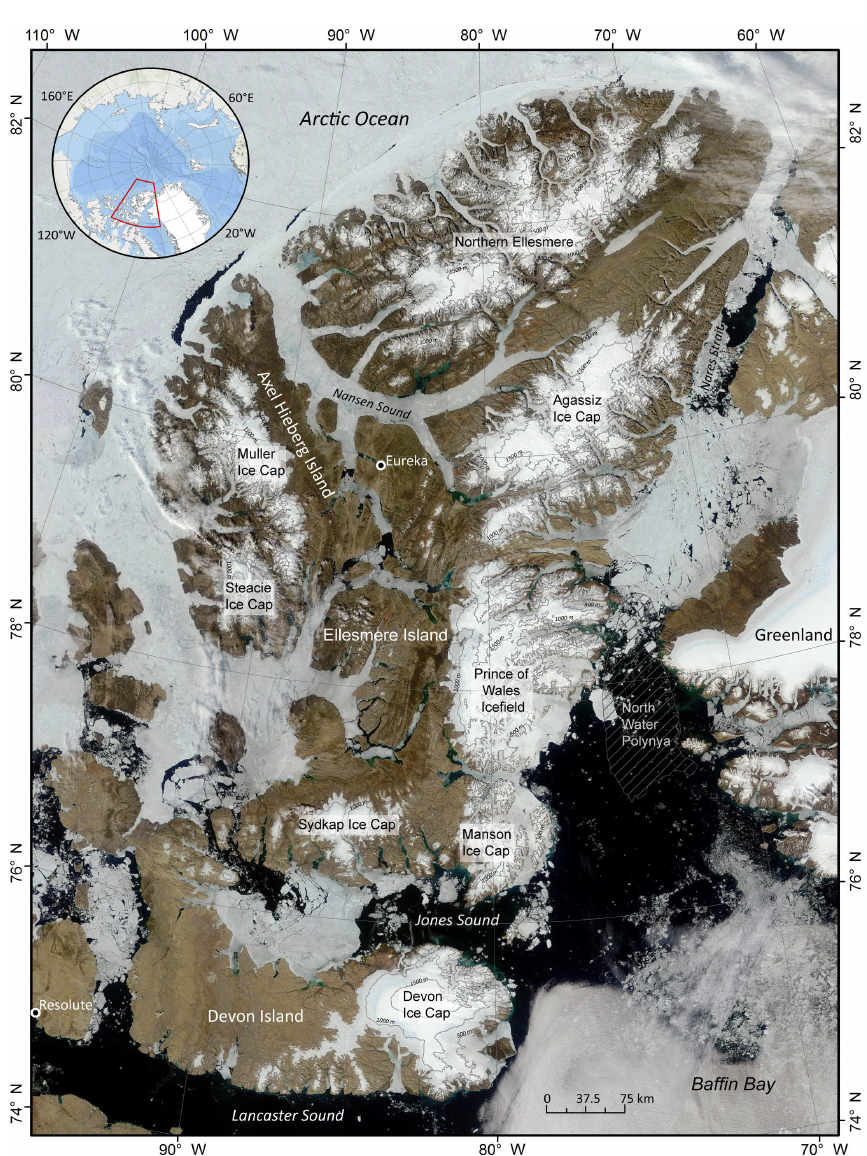
Figure 1. Glaciated regions of the Queen Elizabeth Islands (QEI). Background image: MODIS, 4 July 2011. Inset: red polygon shows location of the QEI, Arctic